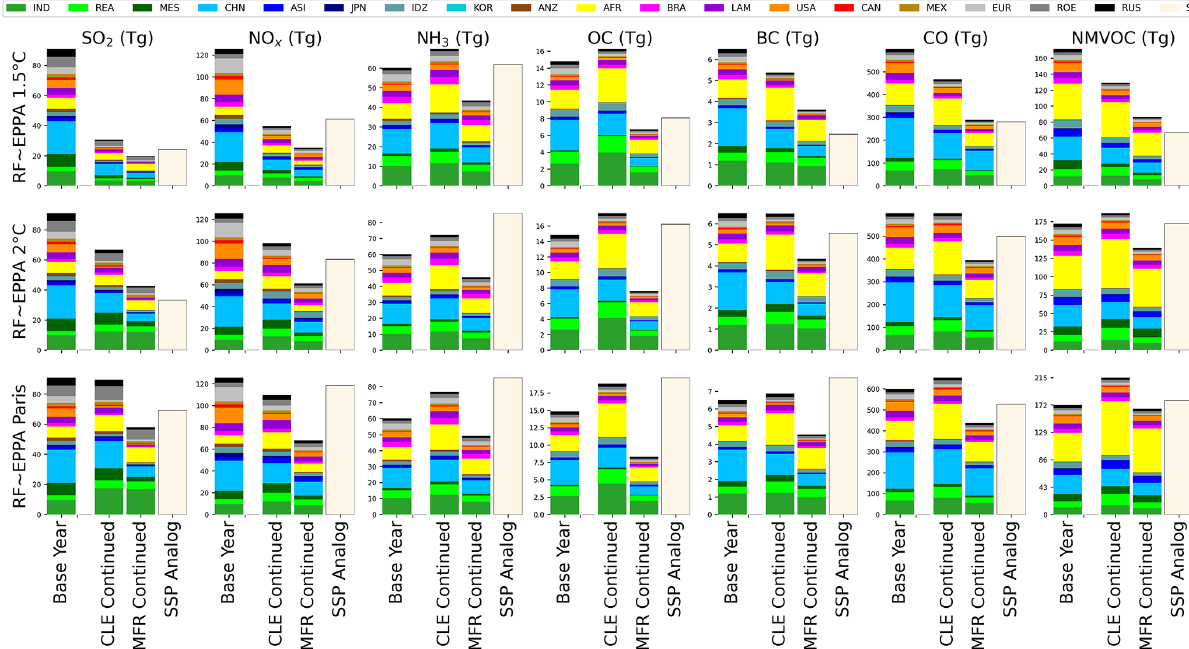
Figure 5. Regional emissions of air pollutants in 2050 under the GAINS-based scenarios of current legislation (CLE) and maximum feasible reduction (MFR) continued – as compared to the 2014 emissions inventories and corresponding CMIP6 scenarios of SSP1-2.6, SSP4-3.4, and SSP4-6.0 (respectively) for EPPA’s 1.5, 2 ◦ C, and Paris Forever scenarios (as in Table 2). See Table B1 for EPPA region abbreviations. The SSP values are shown as global totals due to regional definition discrepancies. Quantities of NO x are in Tg NO 2 ; BC, OC, and NMVOC are in